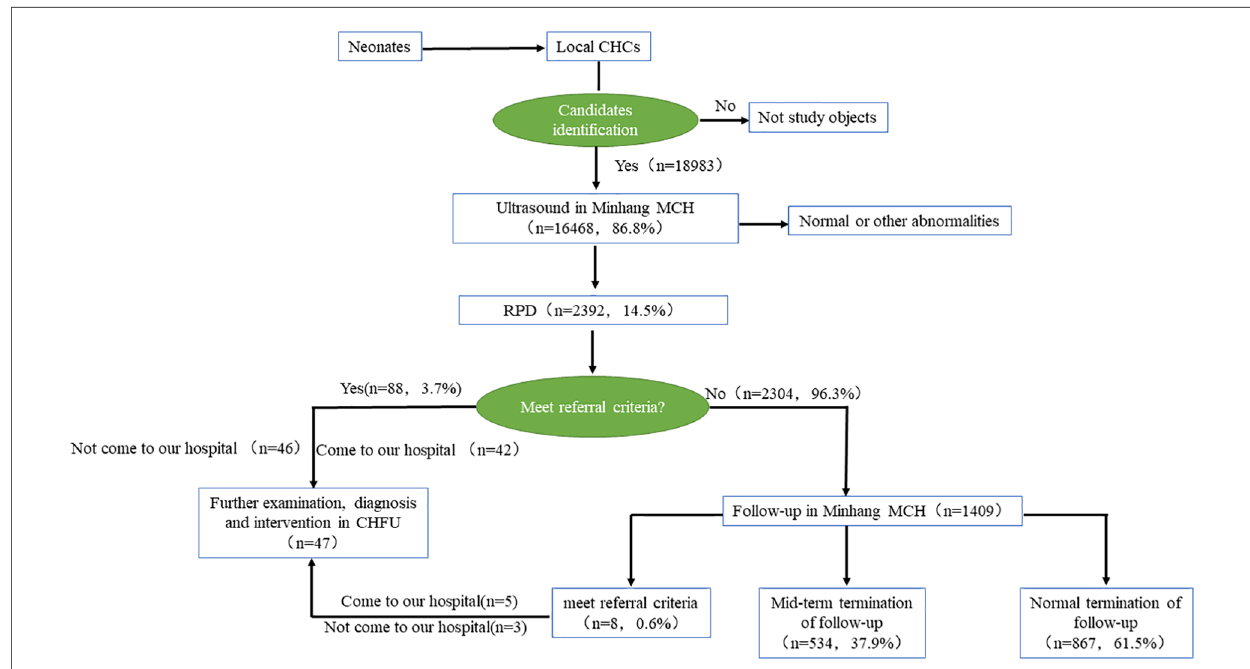
FIGURE 1 Flowchart and general information of research objects. CHCs, community health centers; MCH, maternal and child health hospital; RPD, renal pelvis dilatation; CHFU, children ’ s hospital of fudan